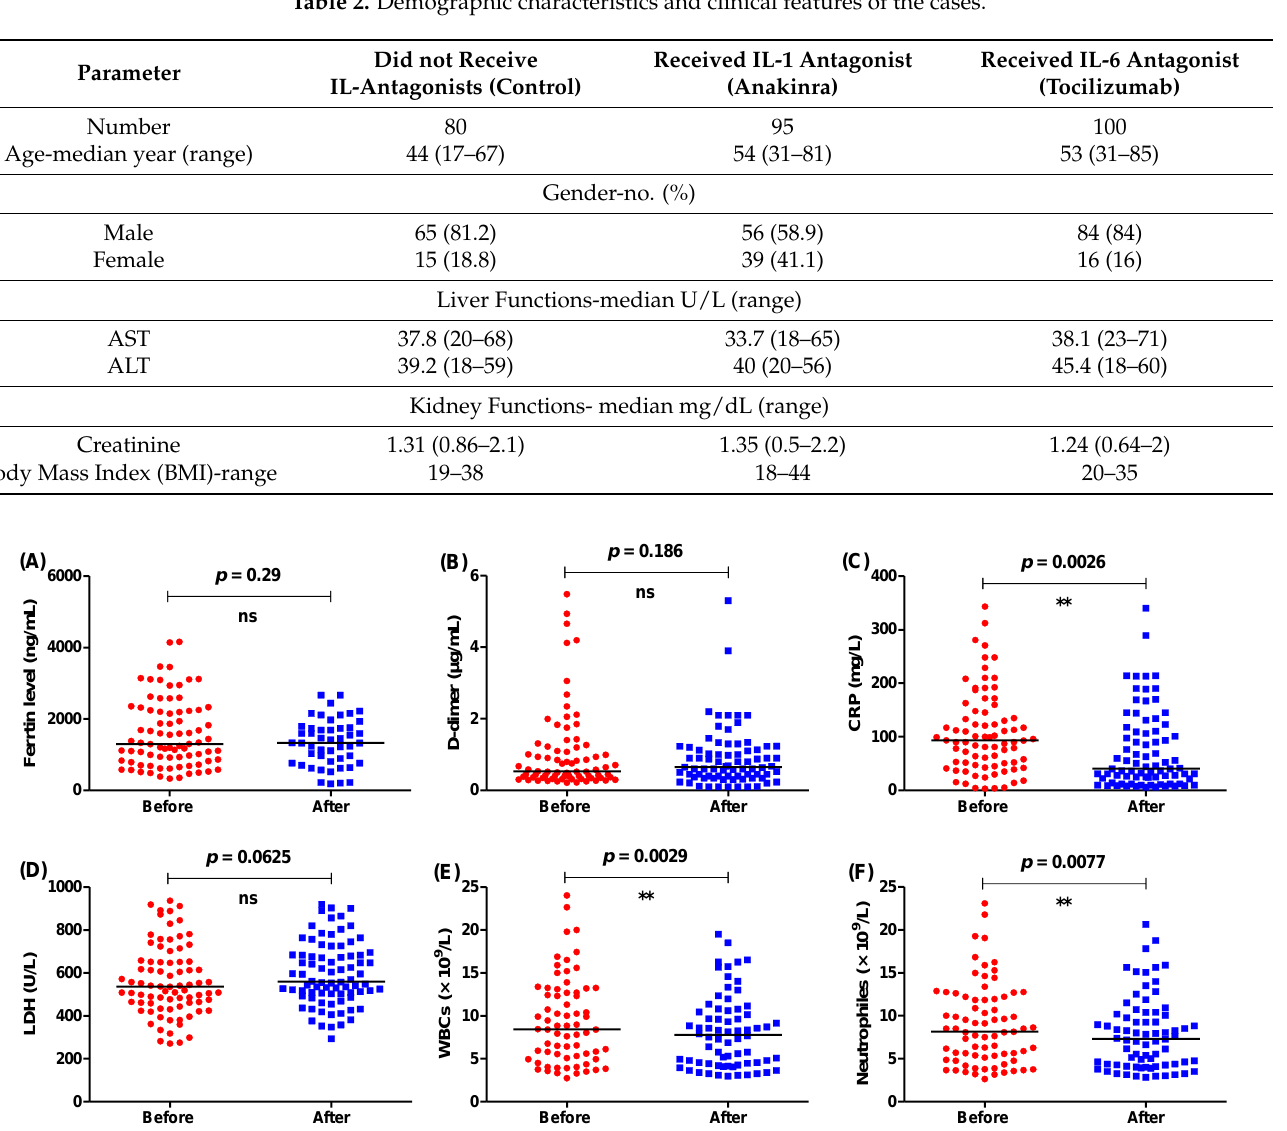
Figure 1. The levels of different parameters before and after administration of treatment regimen without interleukin antagonists. The levels of ( A ) ferritin, ( B ) D-dimer, ( C ) CRP, ( D ) LDH, ( E ) WBCs, and ( F ) neutrophiles were measured before and after completion of treatment regimen, ** = p < 0.01, and ns (nonsignificant) p >